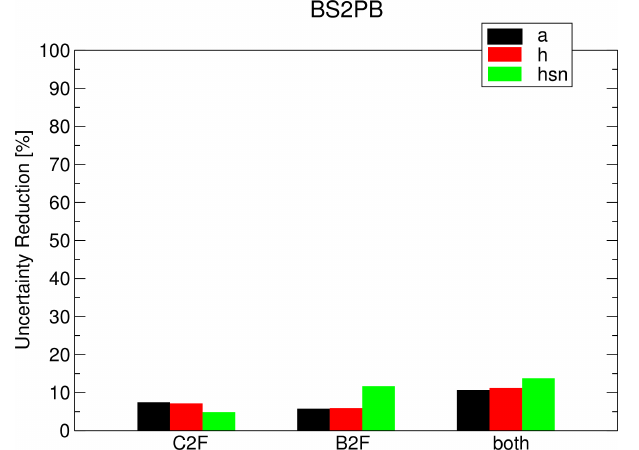
Figure 6. Uncertainty reduction for target area BS2PB for flight transects C2F, B2F, and both.